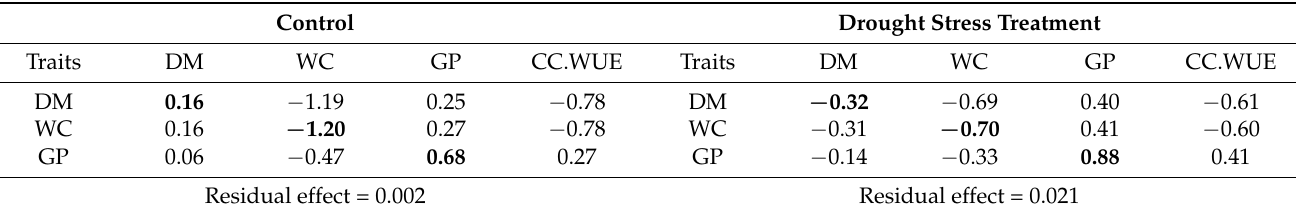
Table 5. Path analysis for the direct and indirect effects of studied traits including days to maturity (DM), water consumption (WC) and grain productivity (GP) on the water use efficiency (WUE) of the lowland rice cultivars under control and drought stress